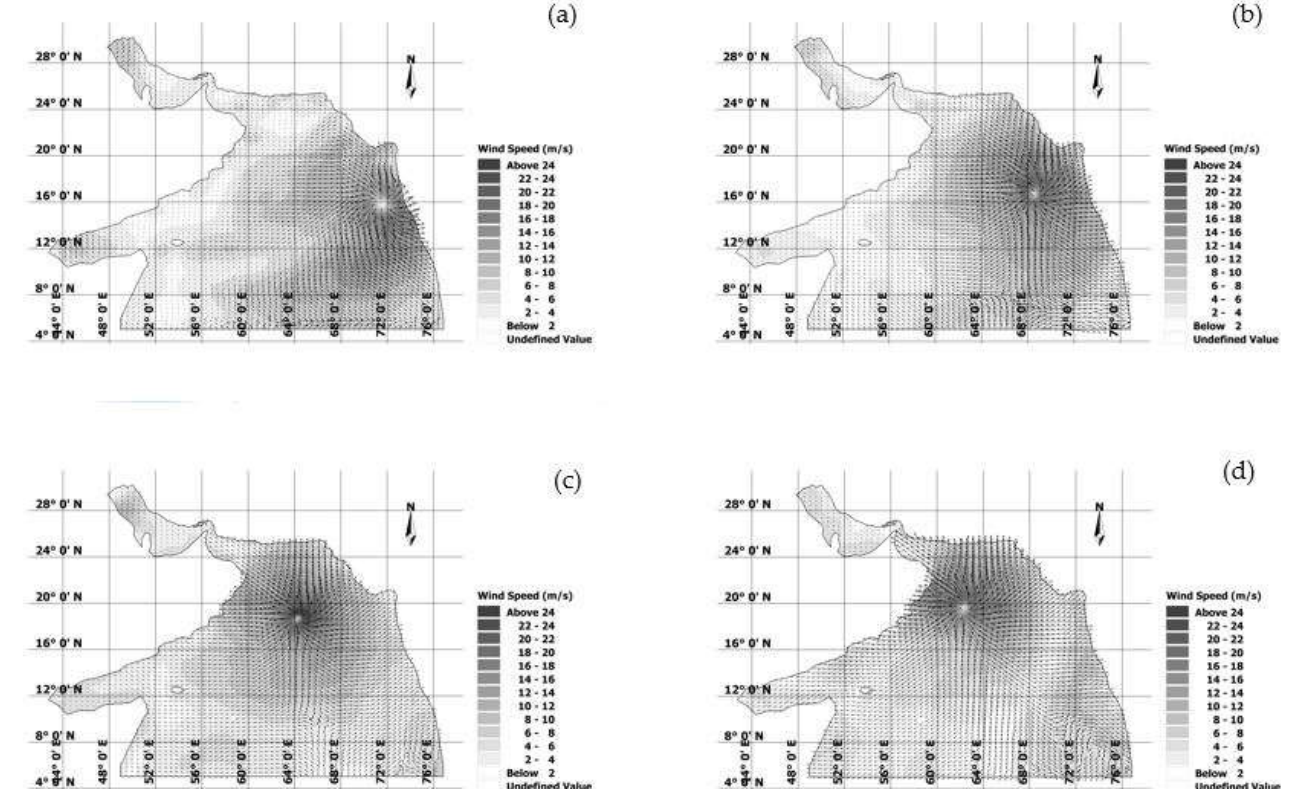
Figure 3. Frequency of very severe cyclones (1891–2011).